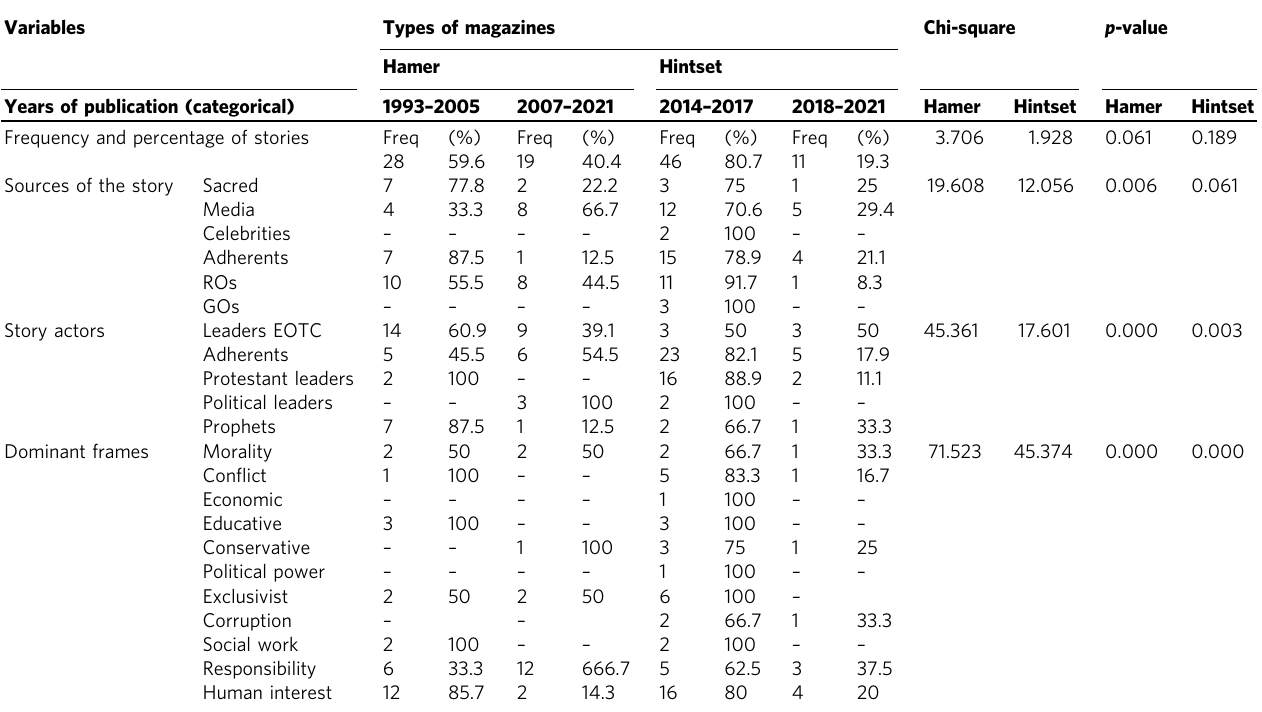
Table 5 Cross-Tabulation: Historic development * Types of publication * Years of publication * Sources * Story actors * Dominant